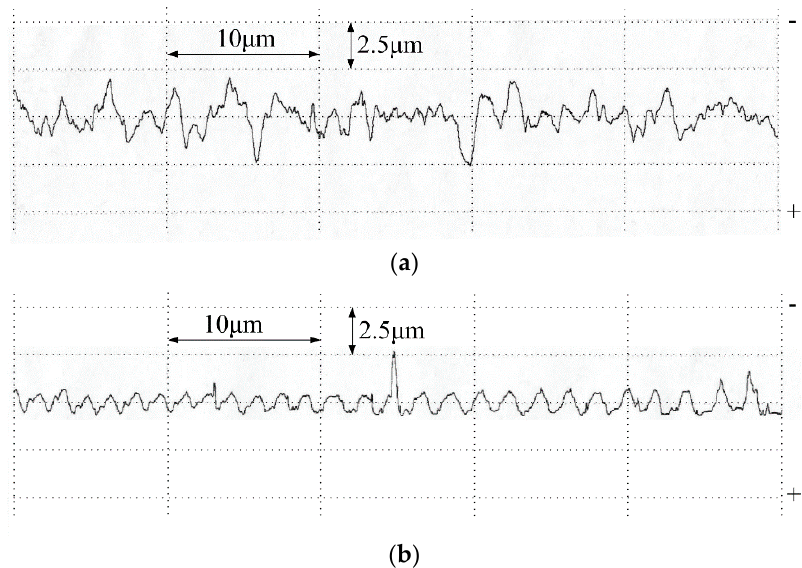
Figure 9. Measured surface roughness profiles of the printed patterns. ( a ) 106 g/L NaNO 3 ; ( b ) 106 g/L NaNO 3 + 30 g/L NaOH.